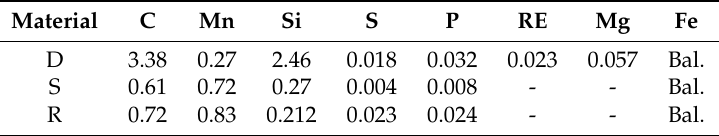
Table 1. Chemical compositions of the testing materials (wt